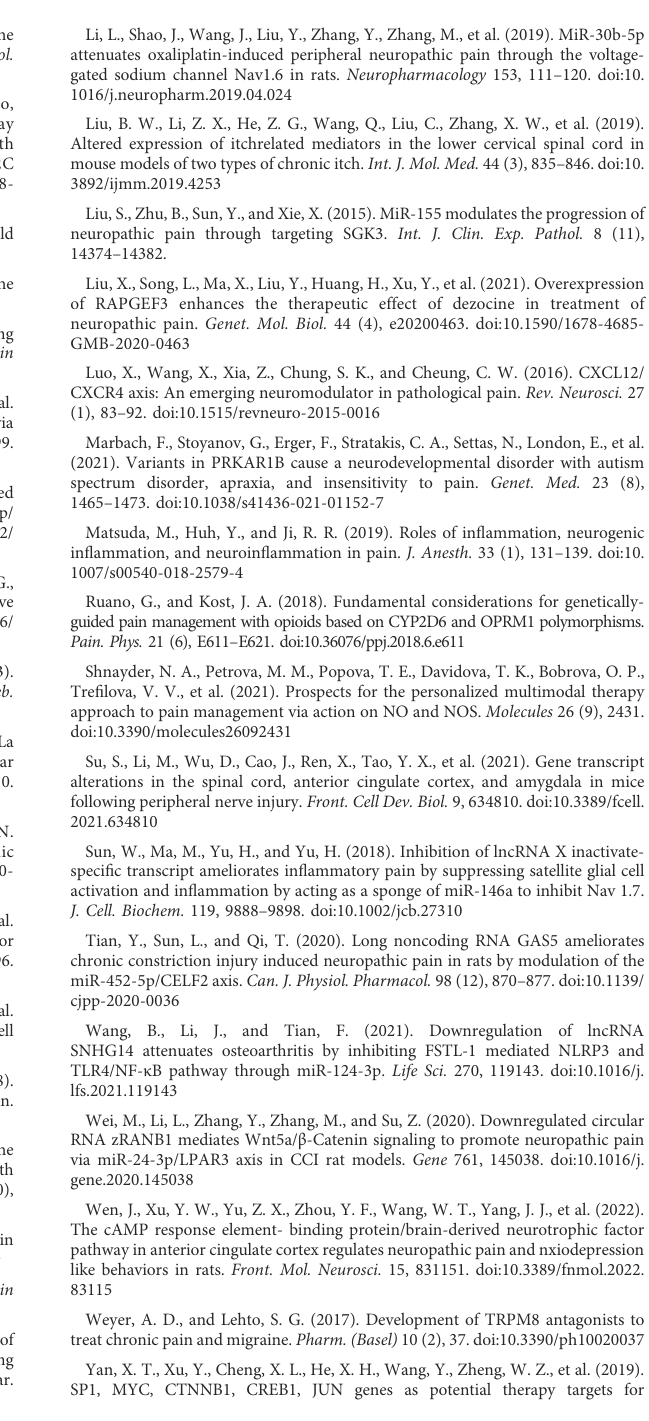
SUPPLEMENTARY FIGURE S2 Functional prediction of DE mRNAs by Gene Ontology (GO) and Kyoto Encyclopedia of Genes and Genomes (KEGG) analyses in the TG of temporomandibular joint disorder (TMD) mice. (A – E) DE mRNAs on CFA3D. (A – C ) directed acyclic graphs (DAGs) graphically display the signi fi cant GO enrichment results with the candidate targeted genes in